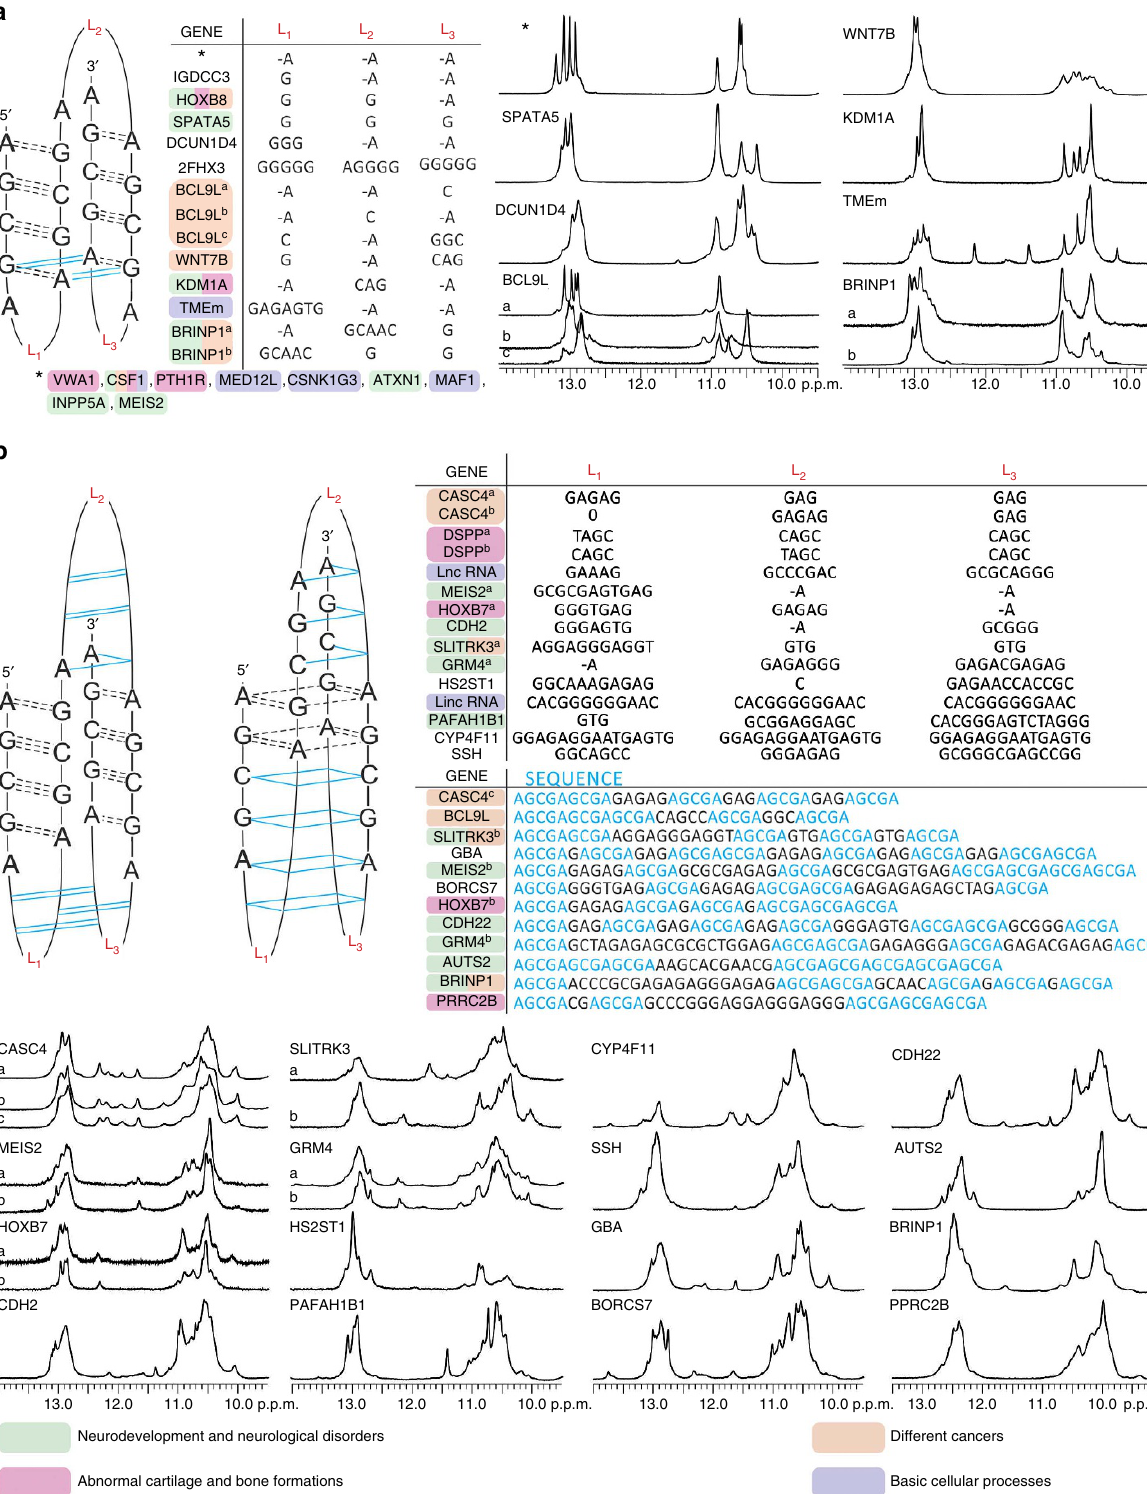
formationsNeurodevelopment Figure 10 | AGCGA repeats found in different human genes with NMR spectra and proposed topologies. ( a ) List of genes and oligonucleotide sequences where 5 0 -AGCGA-3 0 repeats are separated by few residues or experience adenine deletion between two sequential 5 0 -AGCGA-3 0 repeats 5 0 -AGCG_AGCGA-3 0 ( (cid:3) A) with their proposed topology. Expansions of imino regions of 1D 1 H NMR spectra that confirm formation of AGCGA- quadruplexes are shown. ( b ) Two proposed topologies adopted by oligonucleotides where four 5 0 -AGCGA-3 0 repeats are separated by longer loops or that contain more than four 5 0 -AGCGA-3 0 repeats. Respective imino regions of 1D 1 H NMR spectra are shown. The spectra were recorded at oligonucleotide concentrations ranging from 0.6 to 1.1mM, 100mM LiCl concentration, pH 6.0 and 0 (cid:2) C. Colour coding indicates implication of individual gene with family of